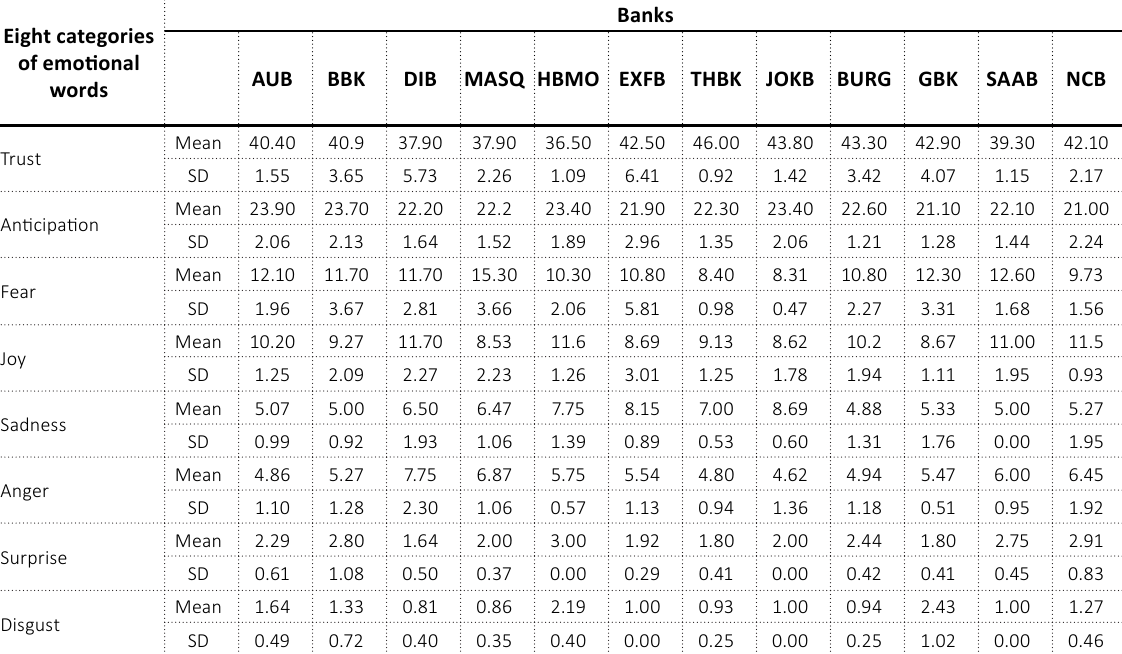
Table 3. The descriptive analysis of the eight categories of emotional words of sampled banks in the current